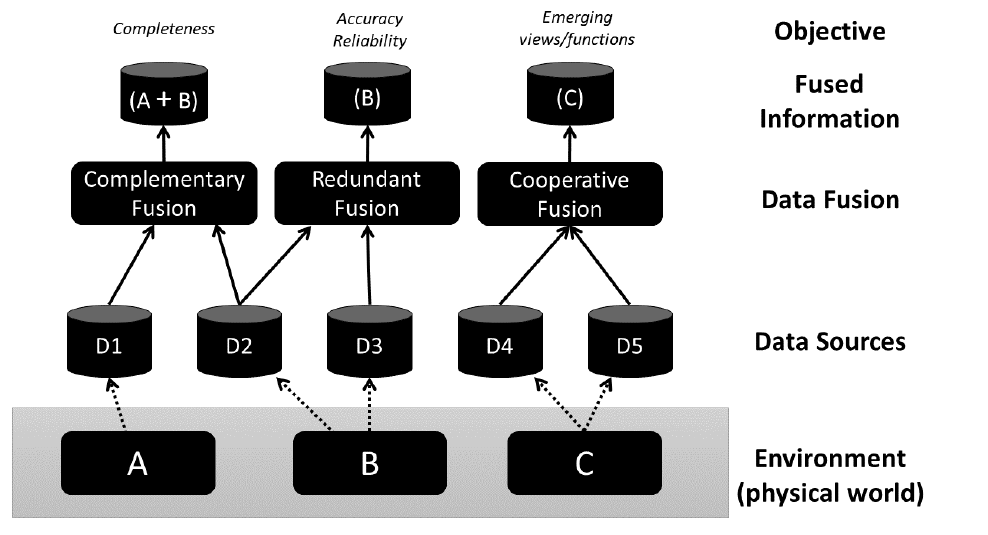
Figure 1. Classification for data fusion techniques. Adapted from Castanedo